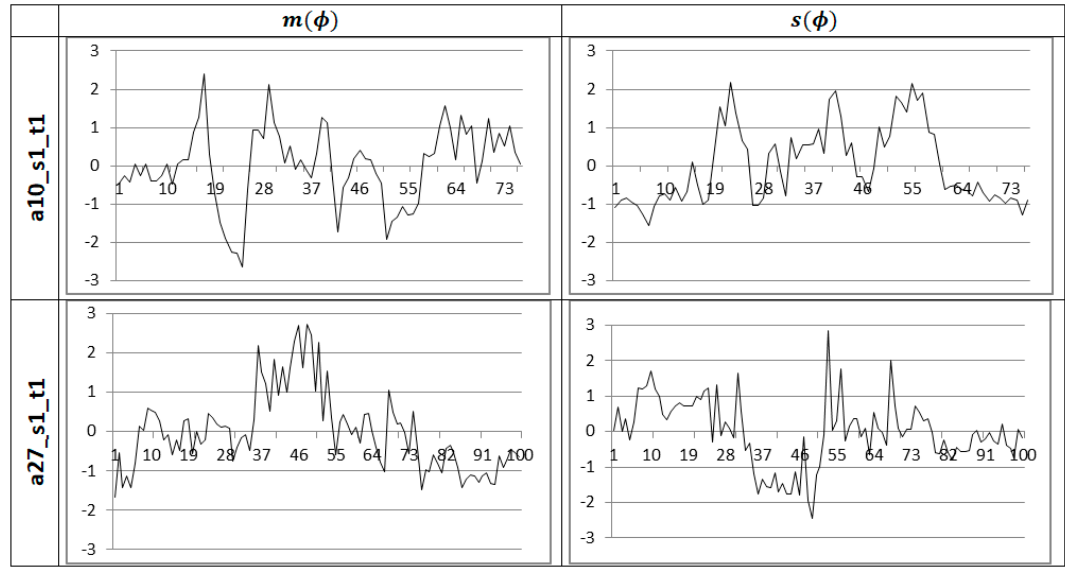
Figure 8. Sample standardized runs of mean and standard deviation for the φ feature of the VFH descriptor for two di ff erent